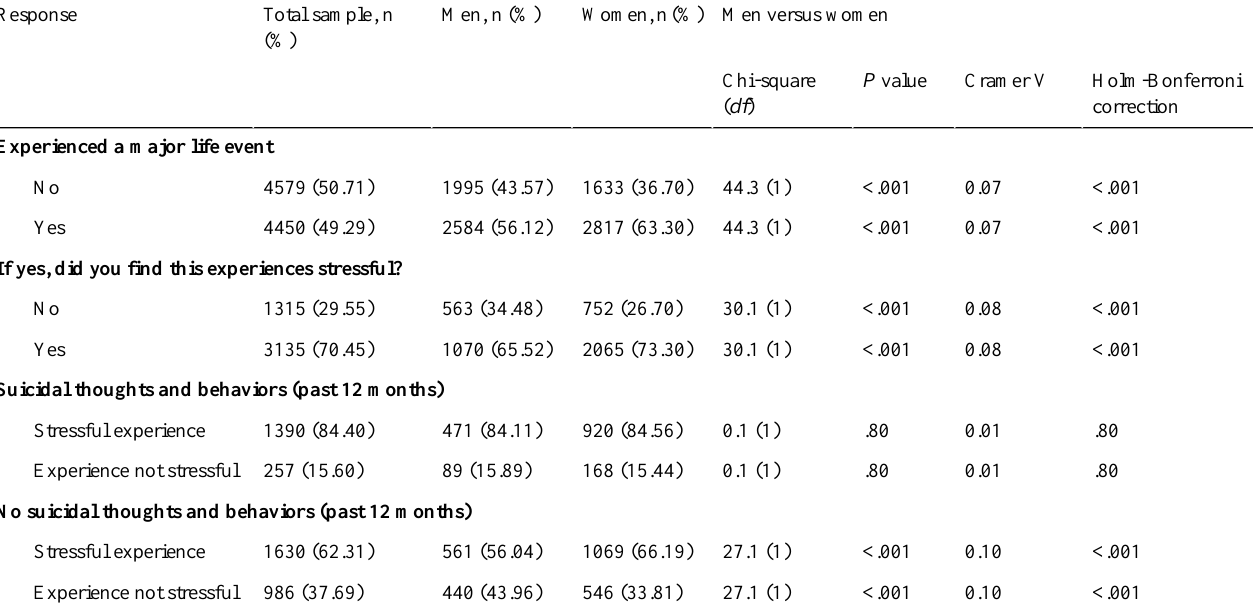
Table 2. Frequency and experience of major life events, stress responses, and suicidal thoughts and